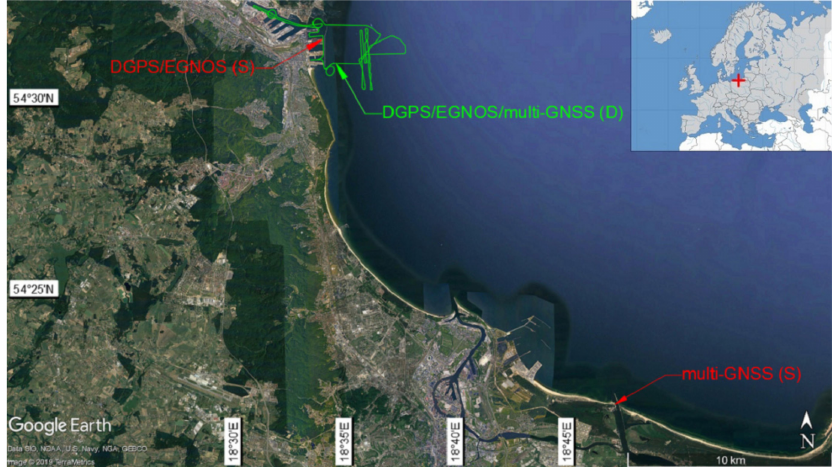
Figure 5. The place of dynamic (D) and stationary (S) measurements of the DGPS and EGNOS systems, as well as multi-GNSS